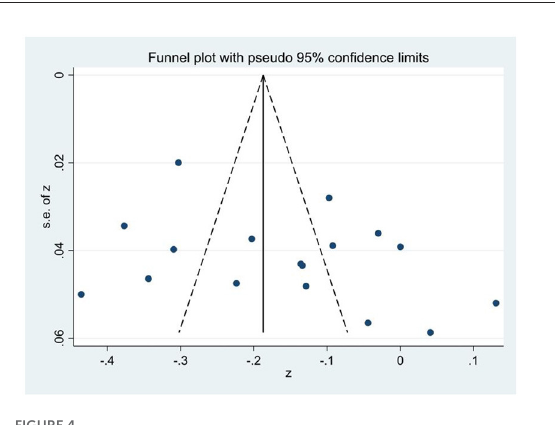
FIGURE2 Funnel plot of the correlation of smartphone addiction and self-esteem.